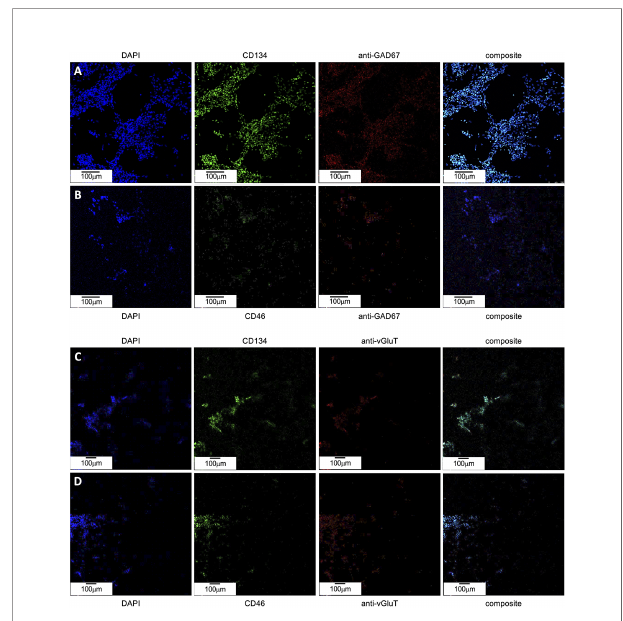
FIGURE 10 | CD46 and CD134 colocalize with GAD67-positive and VGluT- positive differentiated H9 stem cells. (A) GAD67-positive ( red, mid-right ) dHNSCs at PDD7 stained with DAPI ( blue, left ) exhibit a coincident anti-CD134 immuno fl uorescence signal ( green, mid-left ). (B) GAD67-positive ( red, mid-right ) dHNSCs at PDD7 stained with DAPI ( blue, left ) also show colocalized anti-CD46 ( green, mid-left ). Thus, GAD-67-positive cells appear to express both CD134 and CD46 ( composites, right ). (C) VGluT-positive ( red, mid-right ) dHNSCs at PDD7 stained with DAPI ( blue, left ) also show colocalization of anti-CD134 immuno fl uorescence signal ( green, mid-left ). (D) VGluT-positive ( red, mid-right ) dHNSCs at PDD7 stained with ( blue, left ) show anti-CD46 immuno fl uorescence ( green, mid-left ). This indicates VGluT-positive cells also express CD134 and CD46 ( composites, right ). [Scale bar = 100